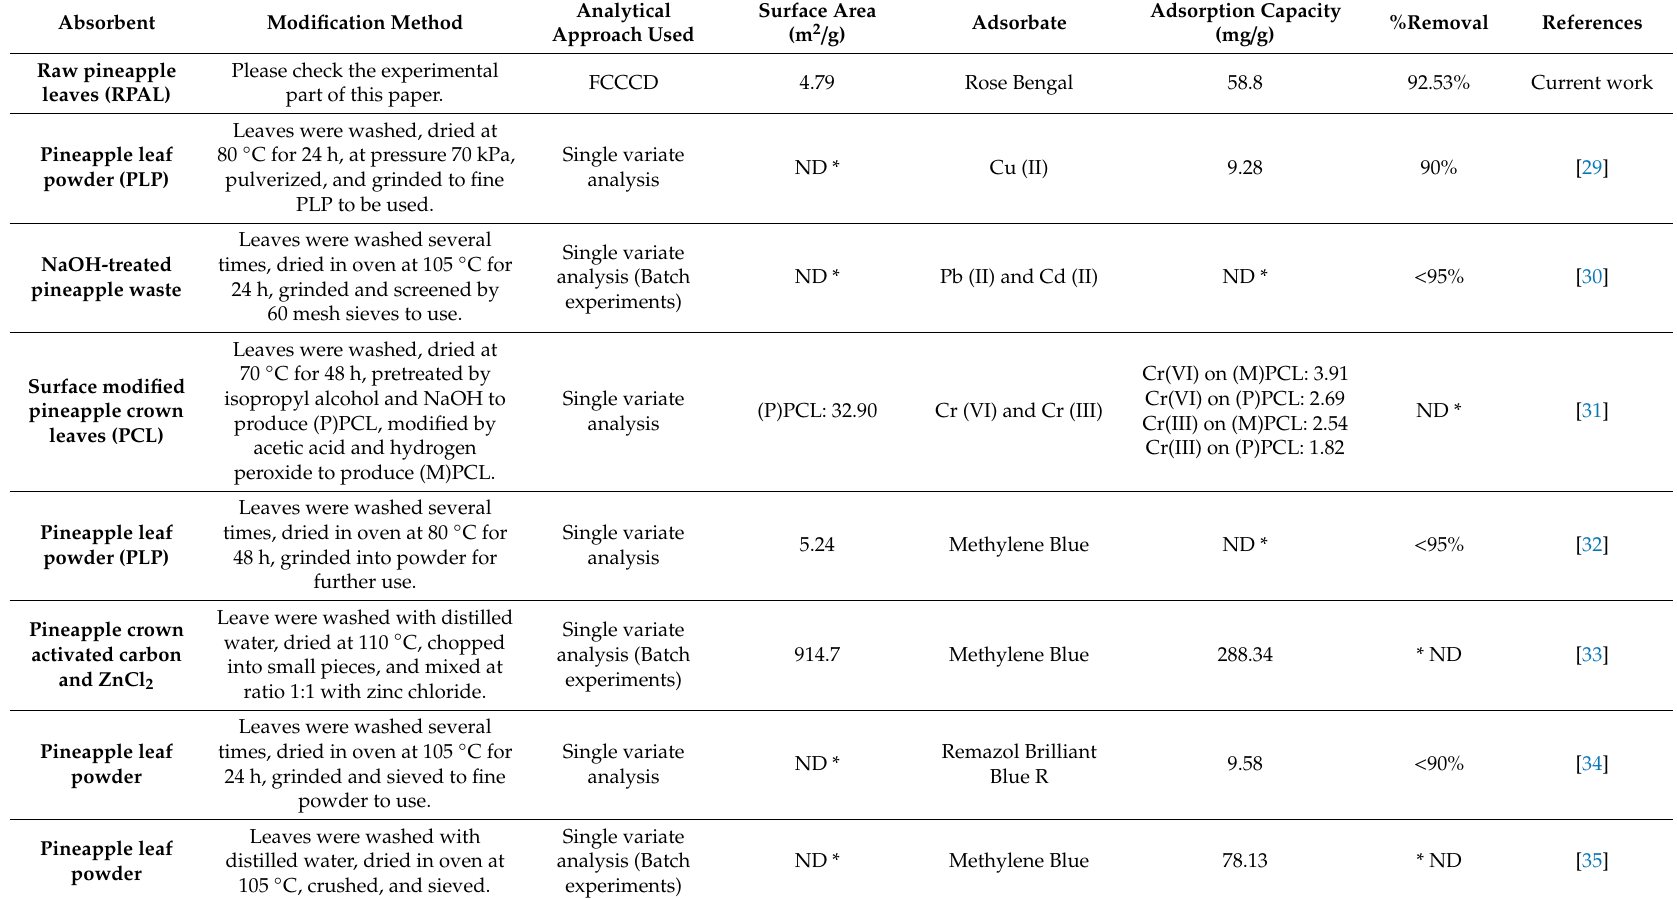
Table 1. Evaluation of the performance of pineapple leaf (PAL) processed in current work compared with other studies used PLP as adsorbent for removal di ff erent